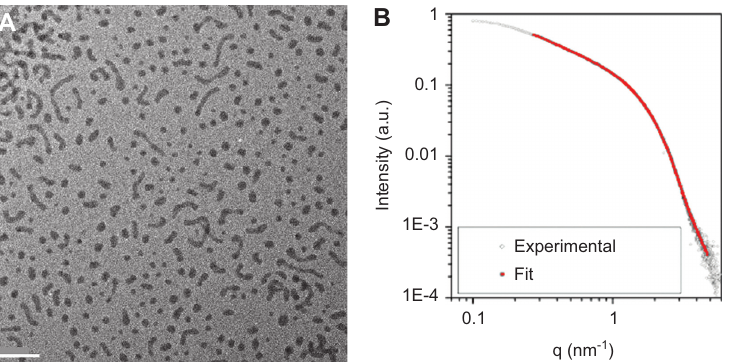
Figure 1 TEM image of the dodecyl amine-stabilized Pd NPs after the phase transfer to toluene (scale bar 20 nm) (A) and the scattering profile of the initial sample (black) and the fit using the IFT method (red)